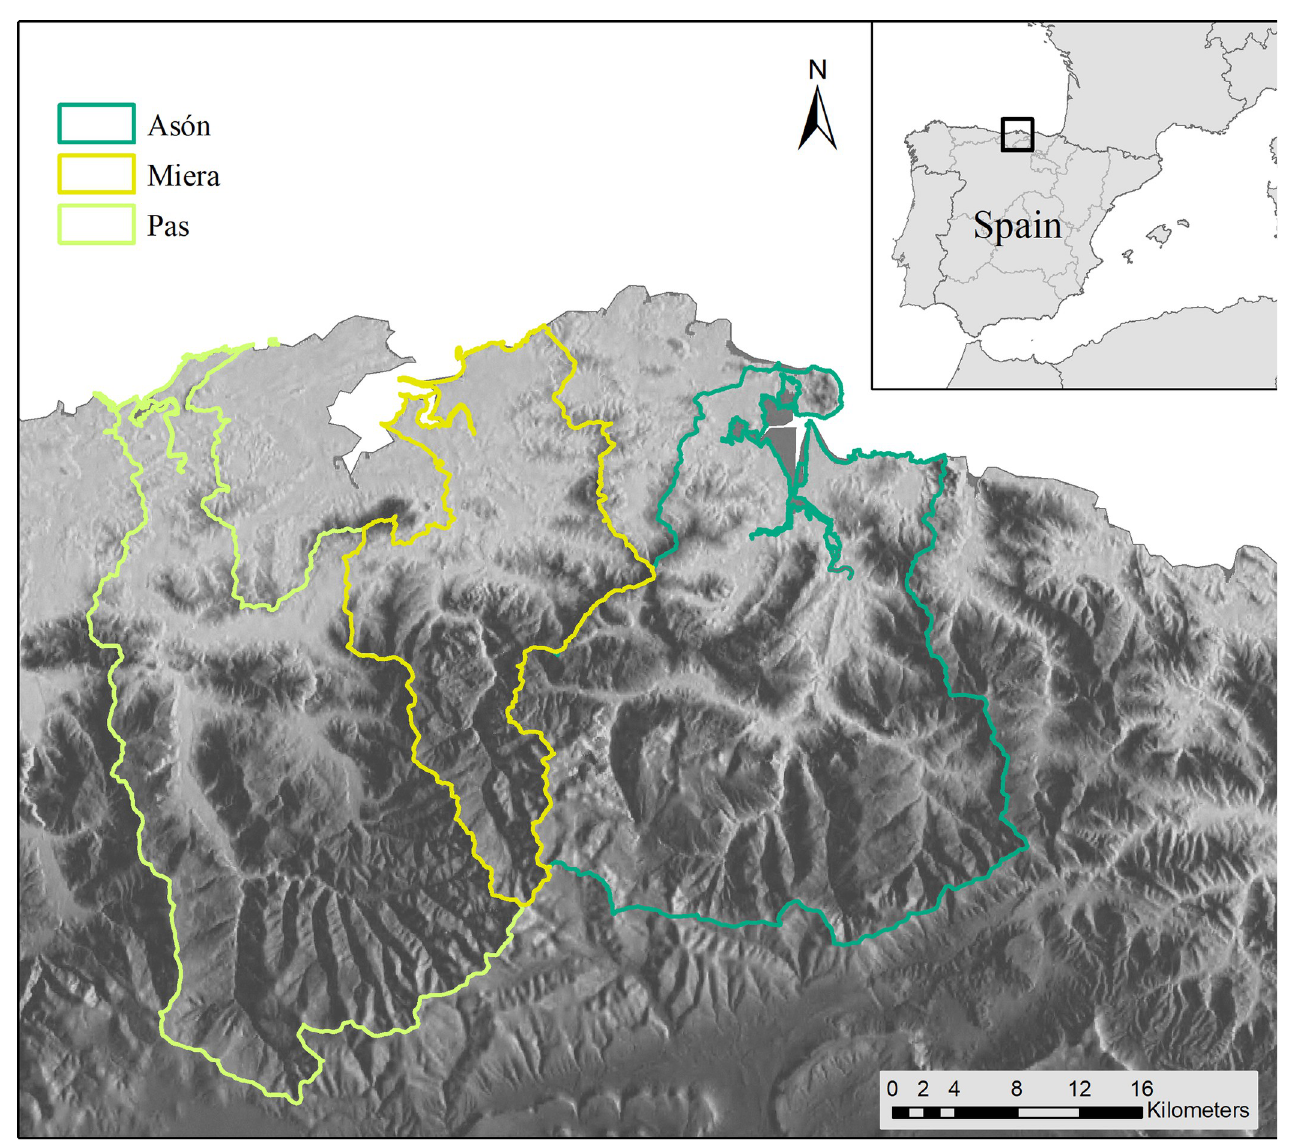
Fig 1. Location of the case study, the Pas, Miera and Ason in watersheds in northern Spain. Reprinted from [67] under a CC BY license, with permission from ISPRS Journal of Photogrammetry and Remote Sensing, original copyright 2014.